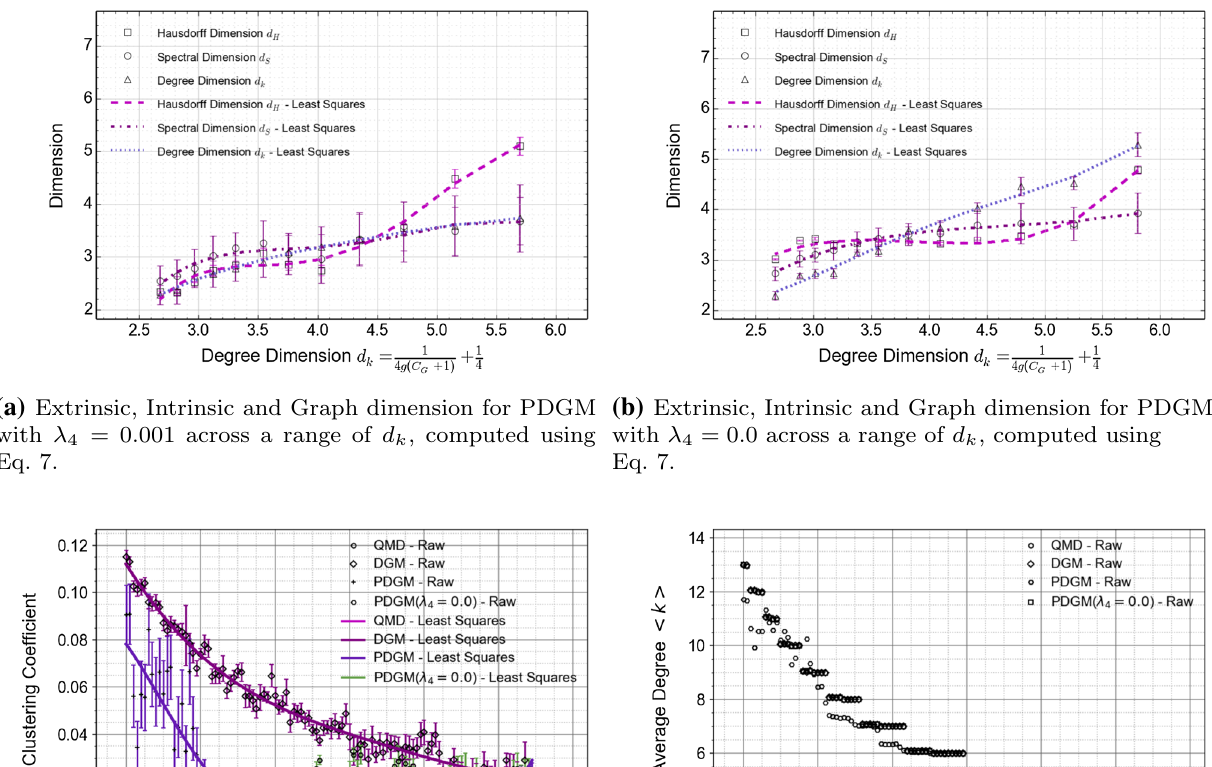
from the mean value. It is evident that the QMD and PDGM models have a significantly lower degree of clustering, but that no